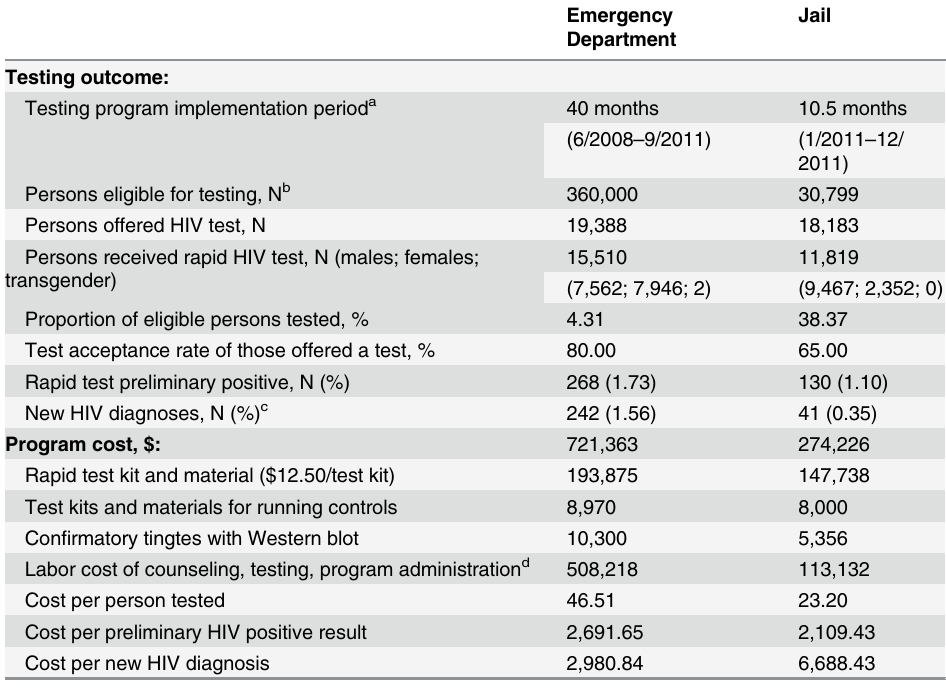
Table 1. Rapid HIV testing outcomes and program costs in Emergency Department (Grady Memorial Hospital) and Jail (Fulton County Jail), Atlanta,